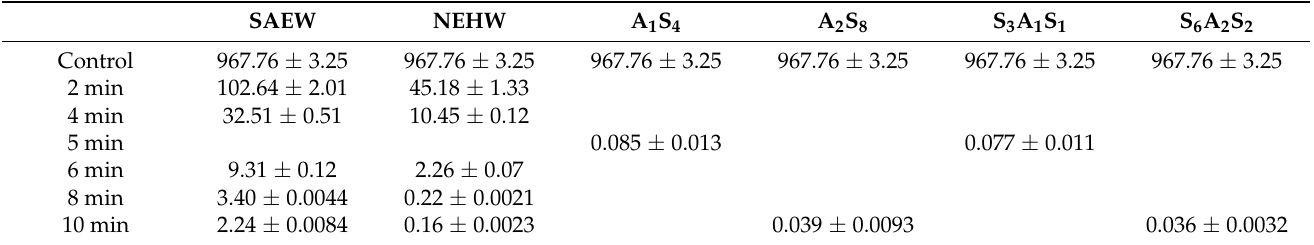
Table 2. The residual eDNA content in the biofilm of Listeria monocytogenes in each treatment.